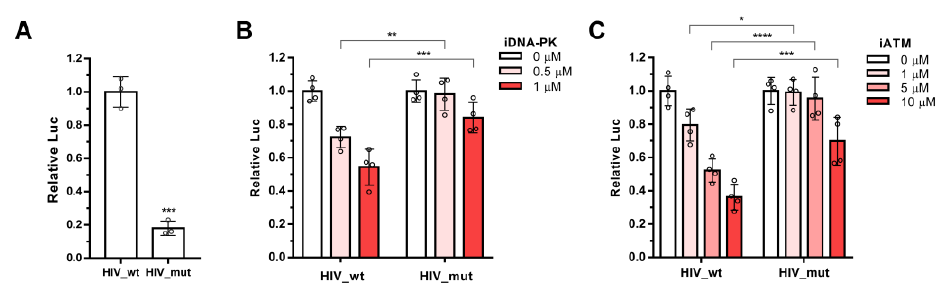
Figure 2. The effect of ATM and DNA-PKcs inhibitors on luciferase activity in 293T cells transduced by HIV_wt and HIV_mut. ( A ) HIV_mut transduced 293T cells five times worse than HIV_wt. Significance was determined by two-tailed Student’s t -test, *** = p < 0.001. ( B , C ) Analysis of the relative luciferase expression in 293T cells transduced by HIV_wt or HIV_mut in presence of increasing concentrations of Nu7441 (iDNA-PK) or Ku-55933 (iATM). Data for HIV_wt or HIV_mut were normalized to 0 μM points for each vector independently. Mean values ± SD of three ( A ) or four ( B , C ) independent experiments are presented. Significance was determined by two-way ANOVA with Sidak’s correction for multiple comparisons, * = adj. p -value < 0.05, ** = adj. p -value < 0.01, *** = adj. p -value < 0.001, **** = adj. p -value < 0.0001.